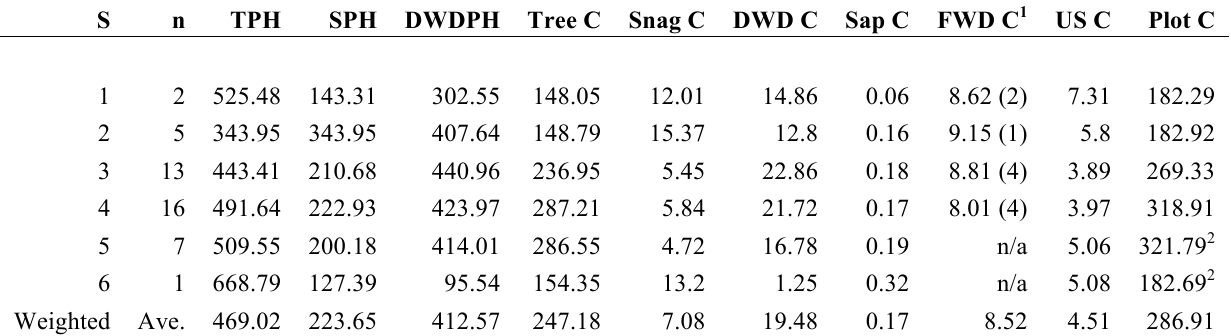
Table 1 . Stand characteristics and carbon (C) pools for measured plots